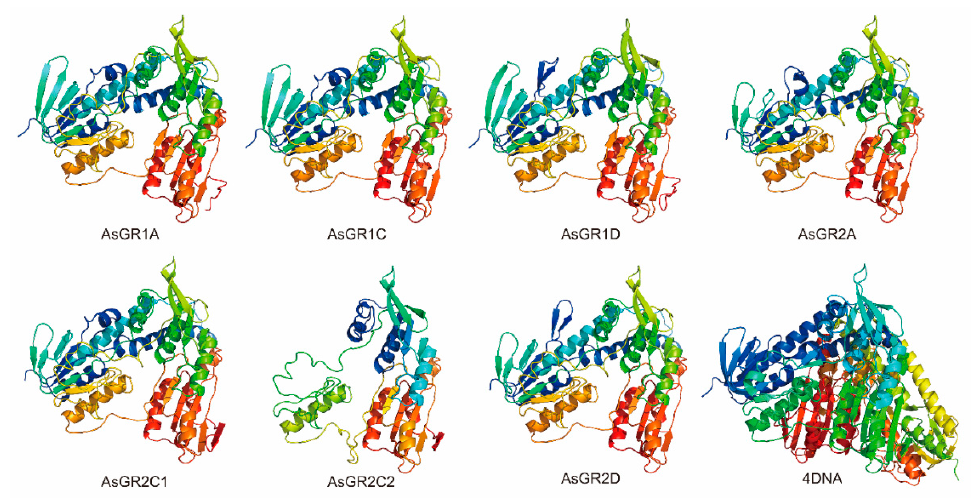
Figure 5. Three-dimensional structure of putative GR proteins from A. sativa generated through homology modelling. All AsGR proteins were modelled using the crystal structure of putative glutathione reductase from Sinorhizobium meliloti 1021 (PDB: 4DNA) chain A as template.